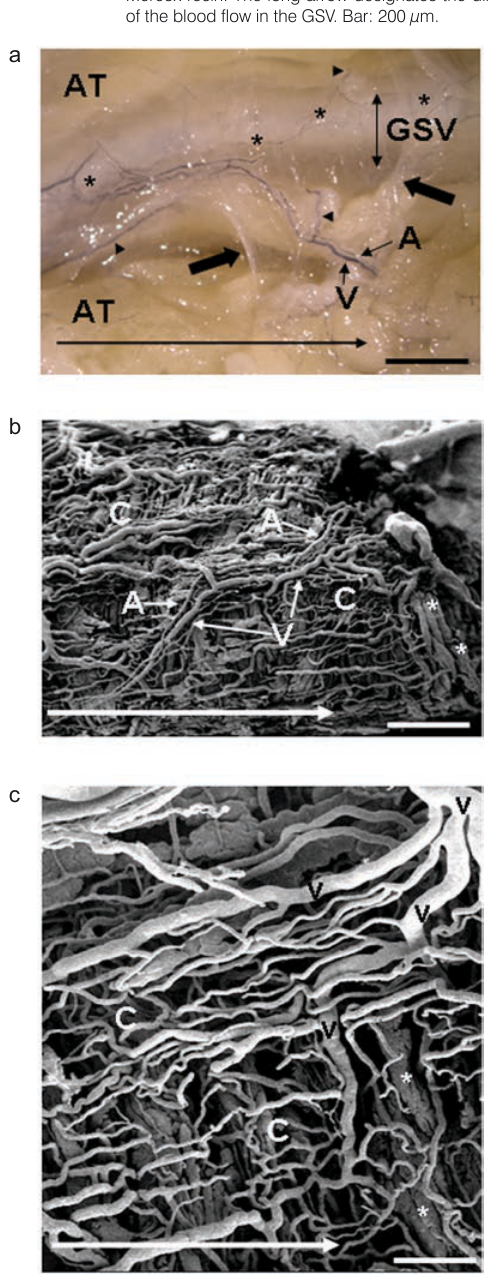
Figure 1. a. Partially dissected inner space of the perivenous compartment (large arrows), containing the adipose tissue (AT) and the GSV. The blood vessels injected with India ink. A,V – feeding artery and vein, arrowheads – branches of the adventitial vessels, asterisks – vessels of the adipose tissue. Long arrow designates the direction of the blood flow in the GSV. Bar: 3 mm. b. Corrosion cast of the vascular network of the GSV wall. A,V – the largest adventitial branches of the feeding vessels, parallel to the longitudinal axis of the GSV (long arrow). C – capillaries. Asterisks – extravasations of Mercox resin. Bar: 500 μm. c. SEM image of venules and capillaries of the GSV wall. C – capillaries, v – venules. Asterisks – extravasations of Mercox resin. The long arrow designates the direction of the blood flow in the GSV. Bar: 200